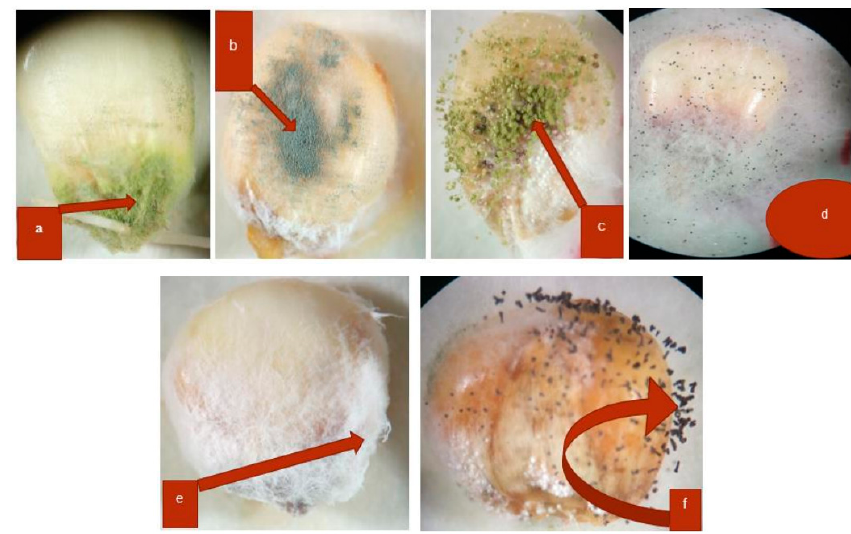
Figure 4. ( a ) Penicillium spp.; ( b ) Curvularia spp; ( c ) Aspergillus flavus ; ( d ) Rhizopus spp.; (e) Fusarium verticillioides ; ( f ) Aspergillus niger (both; ×50).